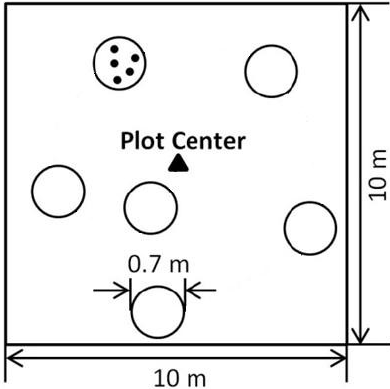
Figure 2. Plot design. Fifteen 10 m × 10 m plots with six subplots spirally arranged around the plot center were set up for data collection in each of the three watersheds. Hyperspectral measurements for each subplot were taken from a 0.4 m 2 circular field of view with a diameter of 0.7 m. Five foliar samples were clipped in each field of view for chemical analysis of leaf nitrogen